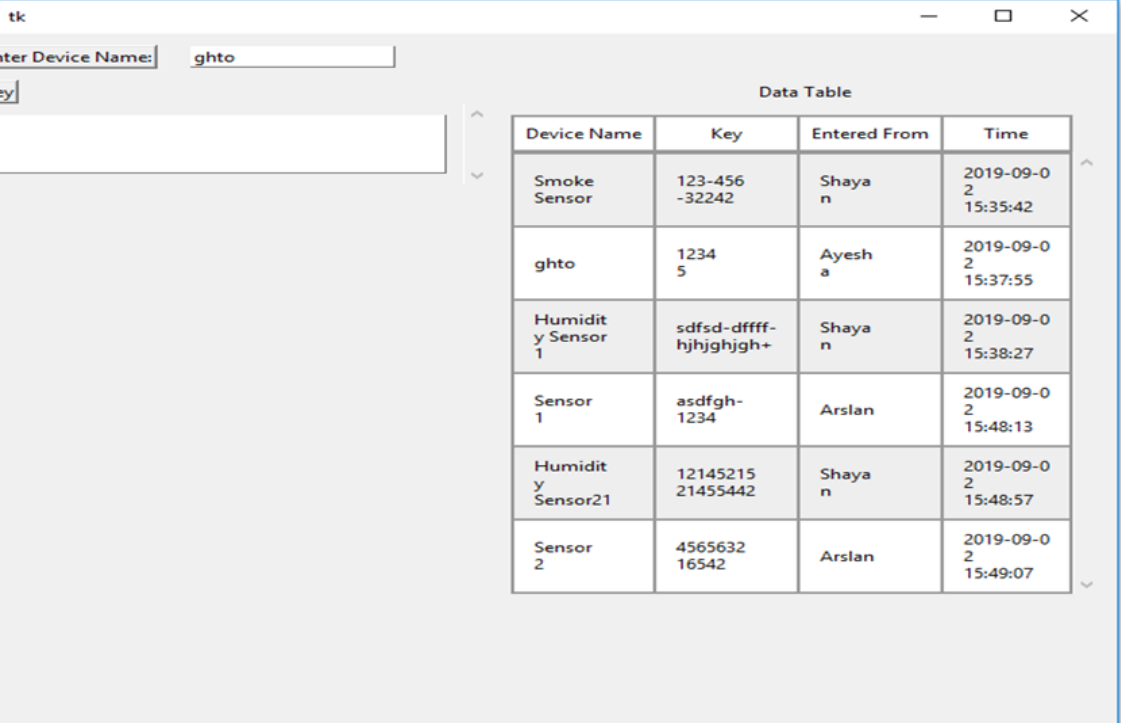
Figure 5. Hash for every record.